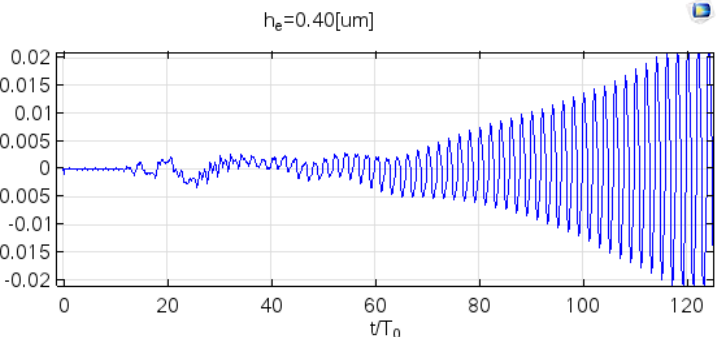
Figure 10. At the position (L/2, h), the vibrational velocity varies with the time period for h e = 0.40 μm.